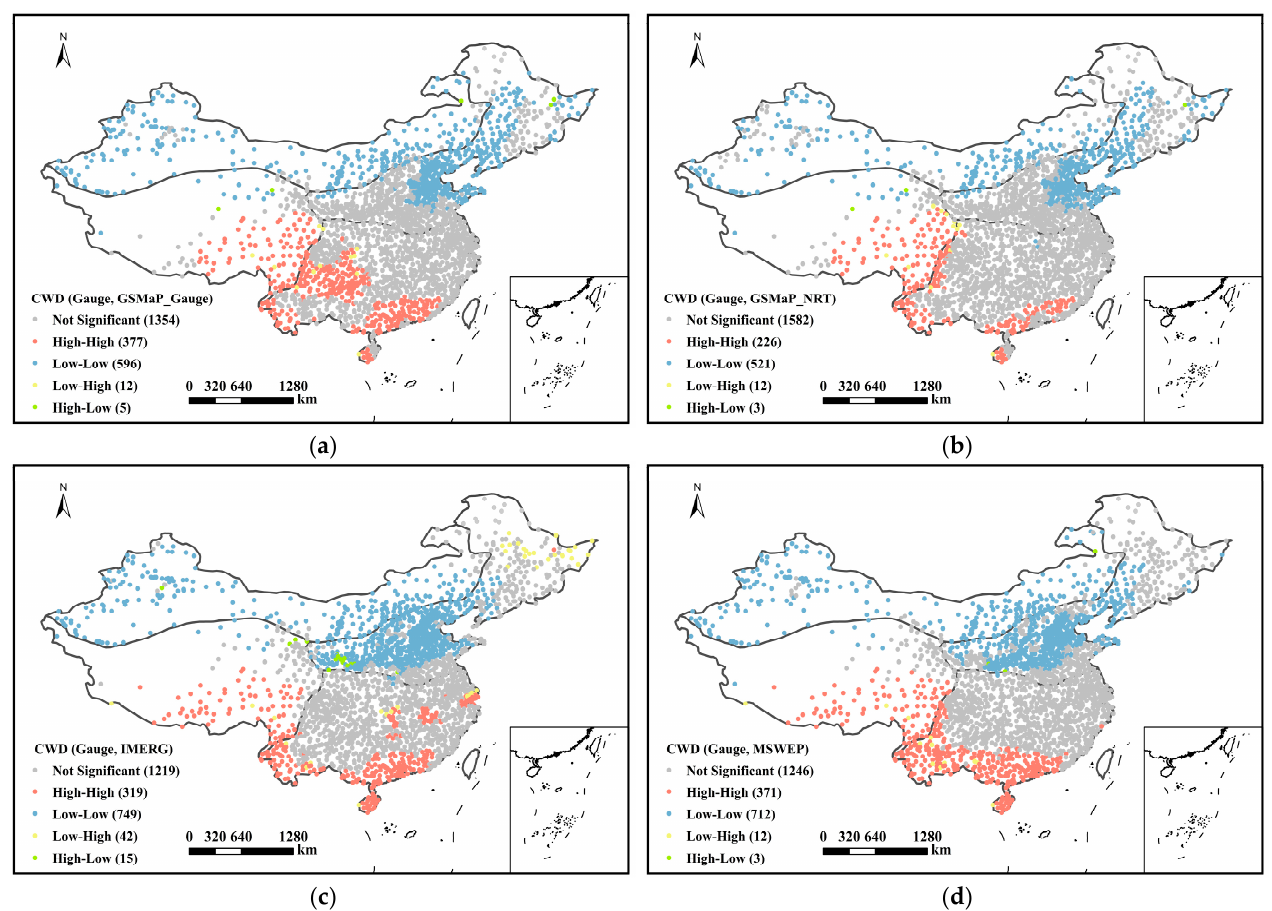
Figure 9. The LISA cluster maps of CWD between the gauge observations and the four SPPs and the number in the bracket represent the corresponding number of gauges: ( a ) GSMaP_Gauge, ( b ) GSMaP_NRT, ( c ) IMERG, and ( d ) MSWEP.